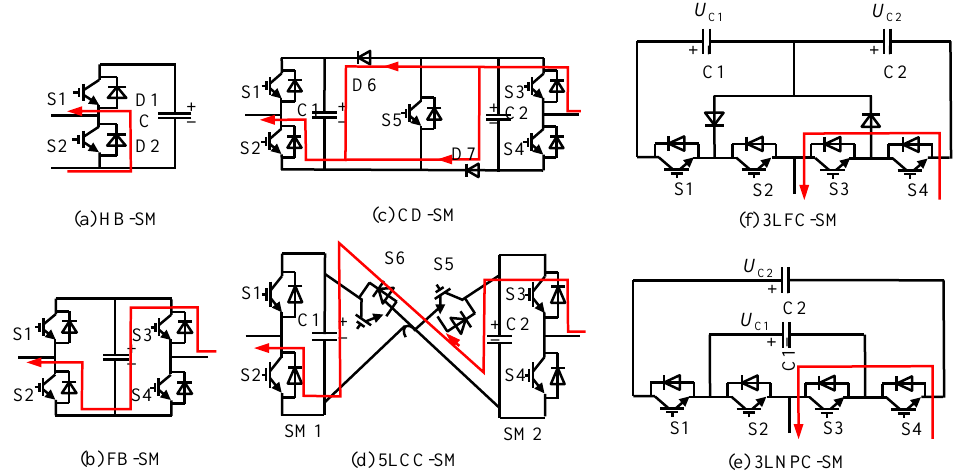
Figure 10. Fault current discharge path of various SM